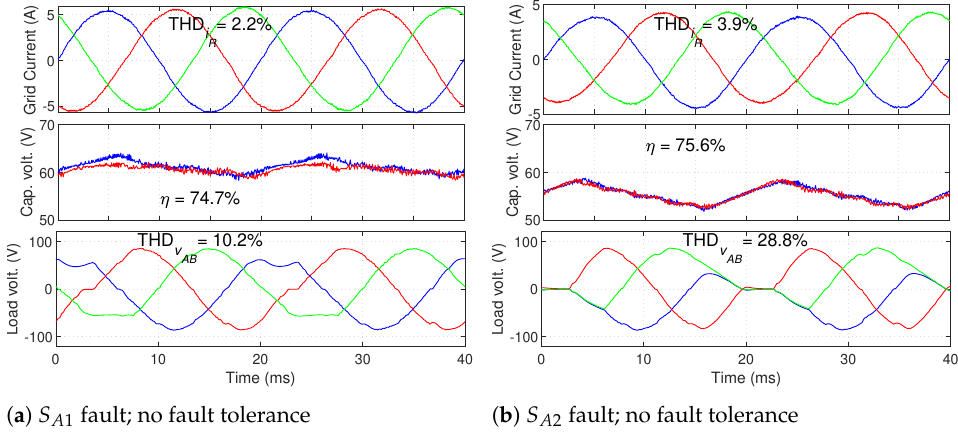
Figure 20. Steady-state UPS operation after a fault in: ( a ) outer IGBT S A 1 ; ( b ) inner IGBT S A 2 . Figure 21 displays the response of the proposed fault-tolerant UPS when a fault occurs in inner IGBT S A 2 of the LSC.